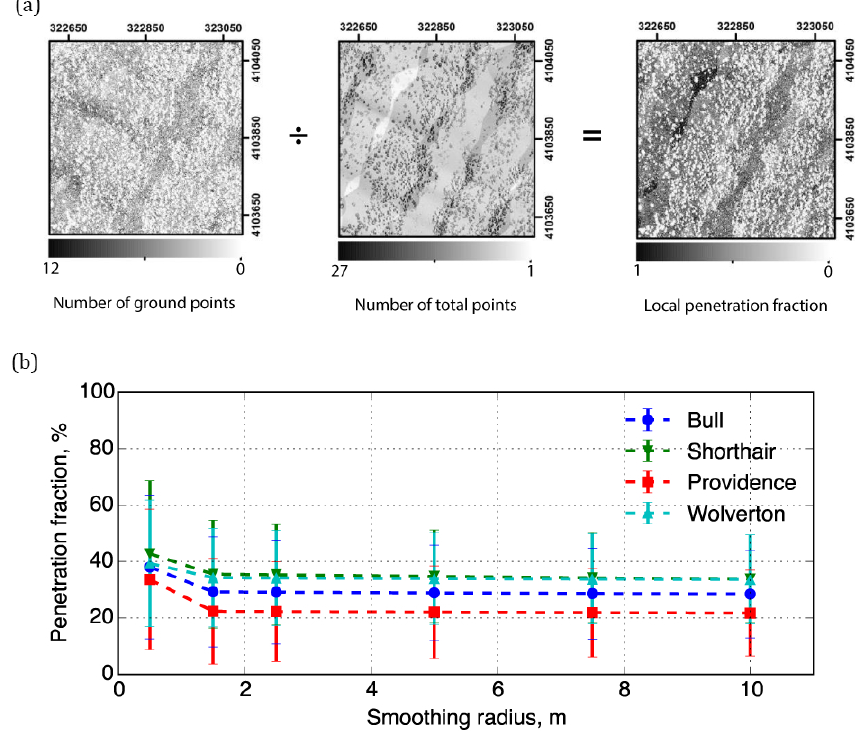
Figure 4. (a) Dividing the number of ground points of each 1m pixel by the total number of points in the pixel gives the penetration fraction of the local pixel. (b) Sensitivity of the smoothed penetration fraction to the smoothing